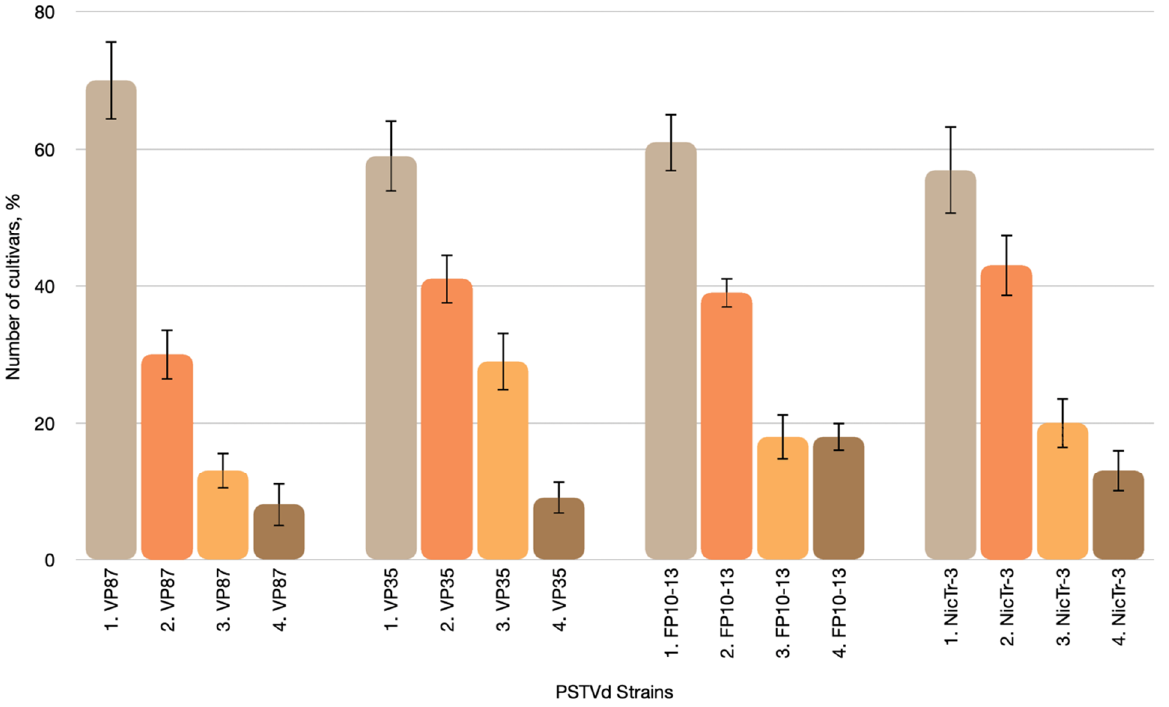
Figure 6. Number of potato cultivars (%) with symptoms of viroid infection of tubers at 90 dpi with four strains of PSTVd: 1—The number of cultivars with normal tuber shape; 2—with all five types of symptoms on tubers; 3—with symptoms of different deformations (except for pear-shaped); 4—with symptoms of pear shape. Differences are significant (Fisher exact one-tailed—0.0001, p < 0.05) between the frequency of cultivars with normal tuber shape (1) and all types of tuber deformation (2, 3, and 4) and between ddeformation symptoms and pear-shaped symptoms when infected with strains VP35, VP87, and NicTr-3.